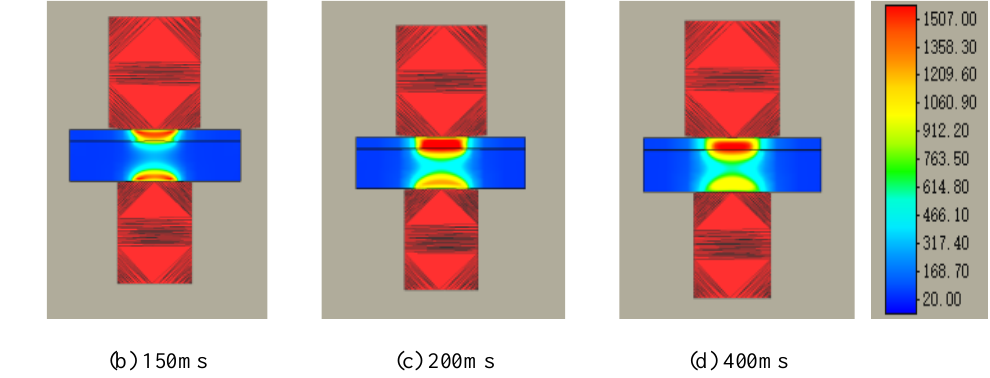
Figure 10. Twin model simulation of resistance spot welding temperature field changes.